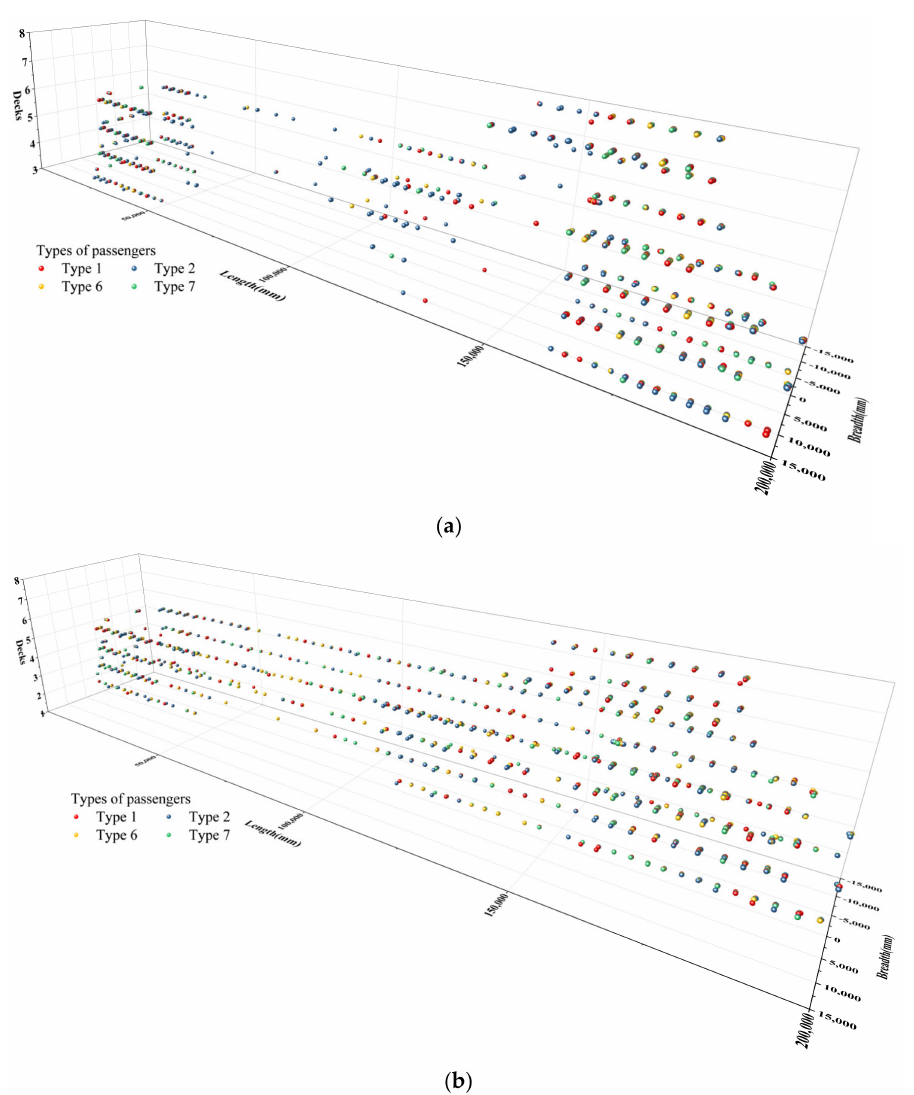
Figure 13. The initial positions of the last 10% of arriving passengers under night scenarios. ( a ) The night-individual scenario; ( b ) the night-group scenario.